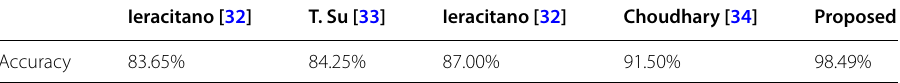
Table 1 Performance